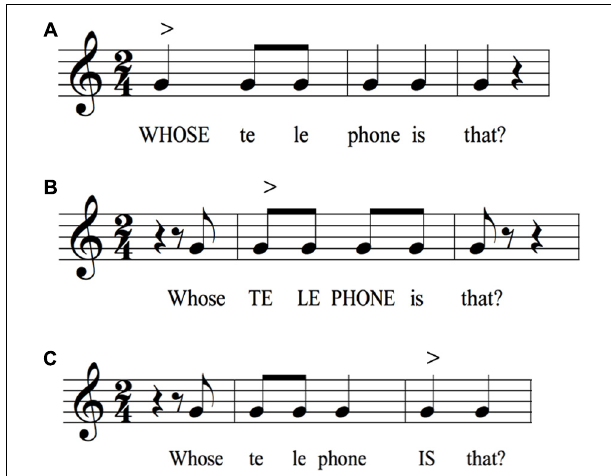
FIGURE 11 | Variability in the intonation of a single sentence. The figure uses rhythmic notation to demonstrate three possible ways of intoning the same string of words, where stress is placed on either whose (A) , telephone (B) , or is (C) . It is expected that different melodic patterns would be associated with each rendition, based on where the point of focus is, which would be an attractor for a pitch rise. The proposed point of narrow focus is represented using bold text in each sentence. The symbol “ > ” signifies a point of focus or accent. The pattern in (A) was most consistent with the analyzed group-average melody shown in Figure 7C